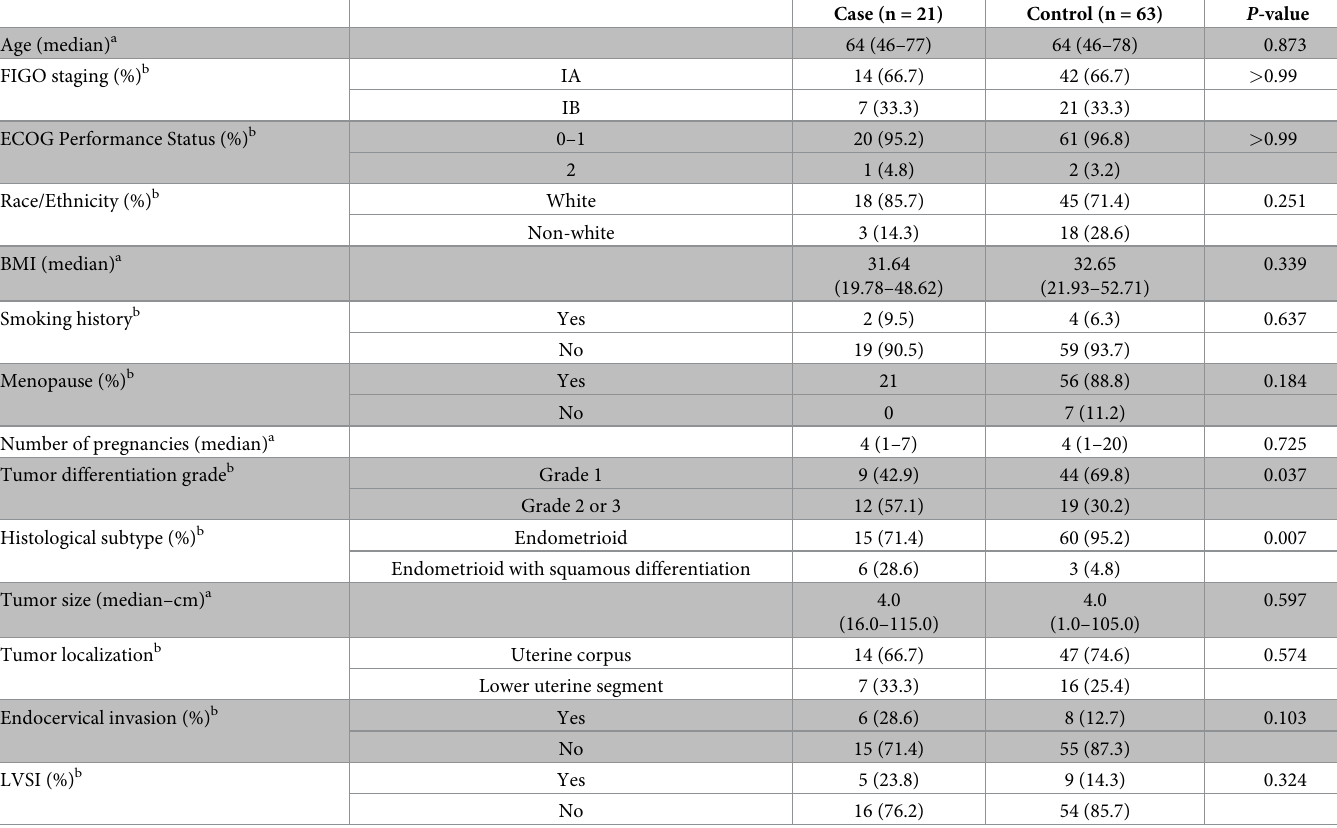
Table 1. Univariate analysis of predictive recurrence for low and intermediate-risk endometrioid endometrial